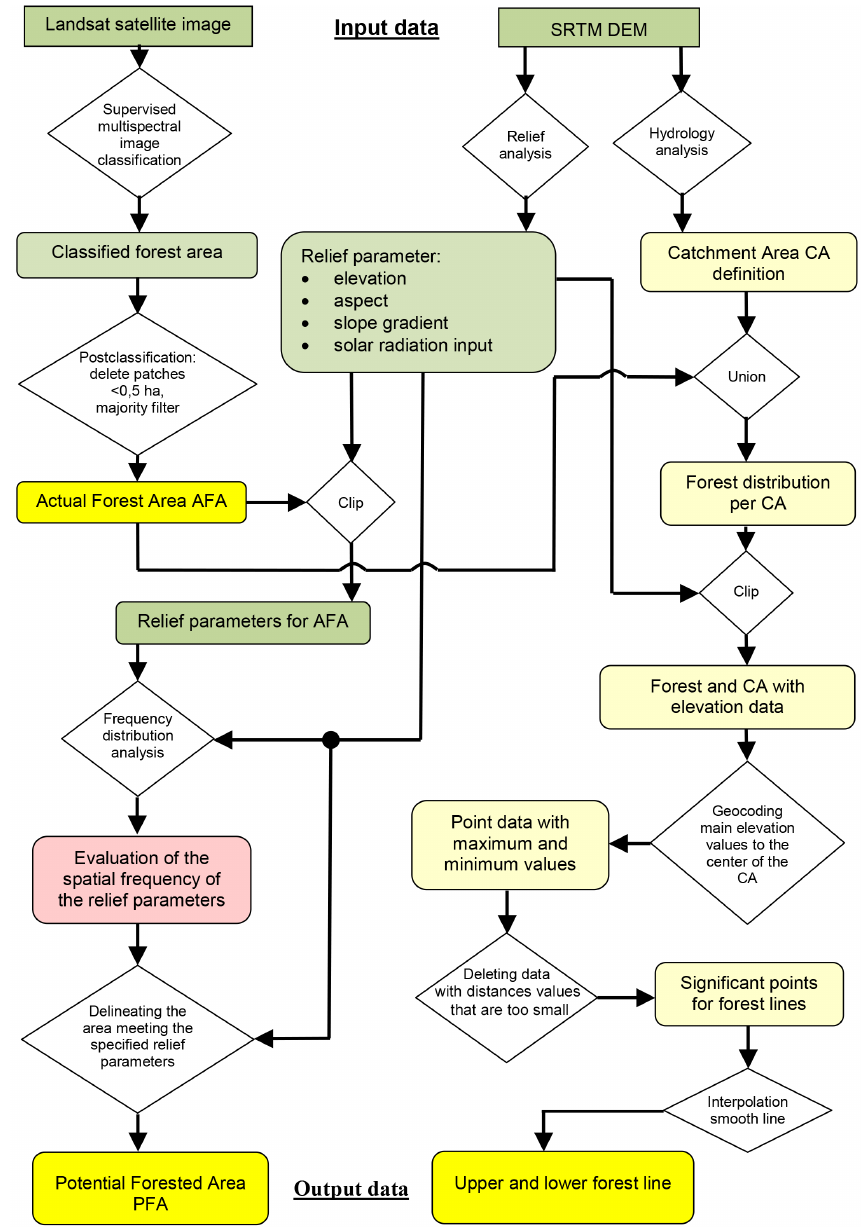
Figure 2. Workflow of DEM (digital elevation model) and satellite image processing to determine the spatial forest distribution patterns in semiarid mountain systems of central Asia on a high-resolution